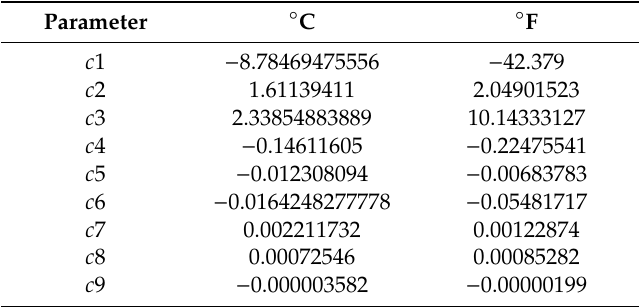
Table A1. Parameters used to calculate the heat index, setting the unit measure of the temperature in ◦ C or ◦ F (Reference [19]).